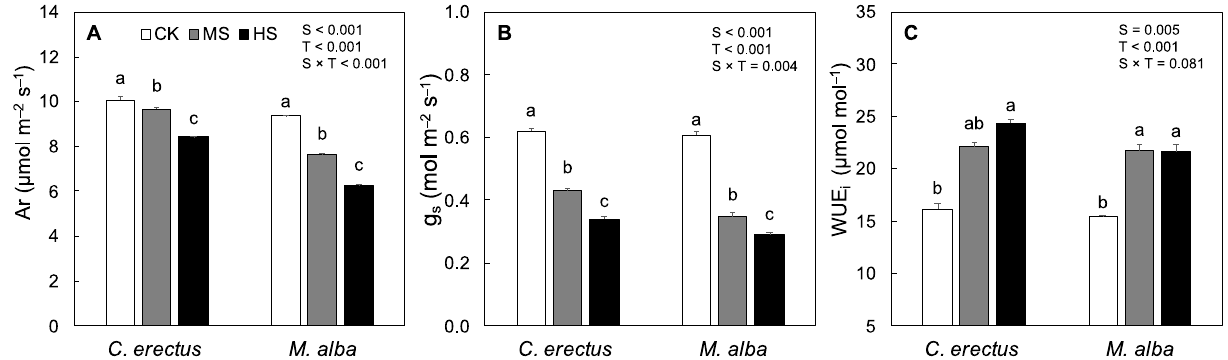
Figure 2. Means values of various gas exchange parameters such as CO 2 assimilation rate ( A ), stomatal conductance ( B ), intrinsic water use efficiency ( C ) under control (CK), Medium (MS) and high (HS) water deficit treatments in C. erectus and M. alba . All the attributes were tested using a two-way ANOVA for species effect (S-effect), treatment (T-effect) and interaction (S × T) effects. All values represent the means ( ± SE) of species in various combinations. Small letters set in bold represent significant difference within each species tested using Dunnett’s test. All the tests were taken to be significant at p < 0.005.